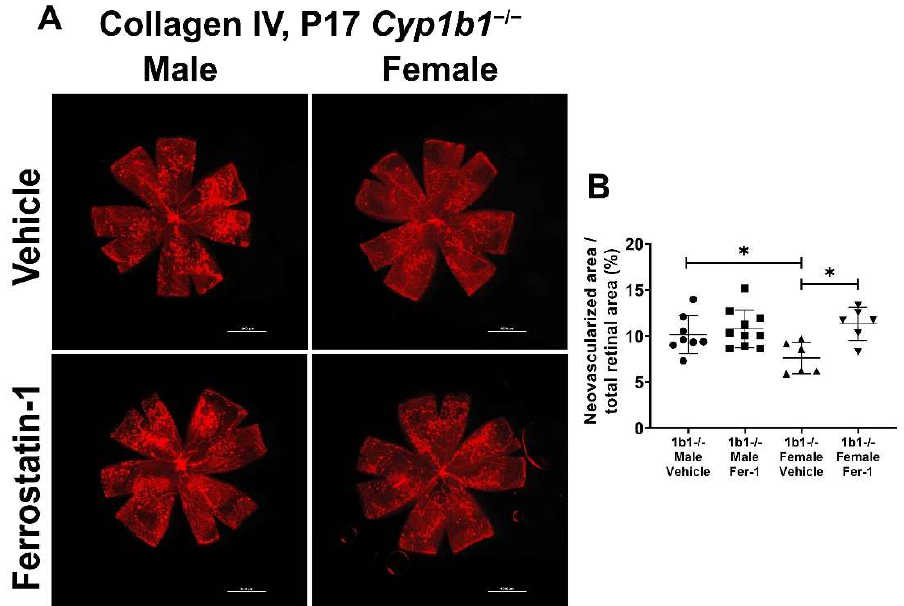
Figure 9. Ferrostatin-1 (Fer-1) administration restored retinal neovascularization in female but not male Cyp1b1 −/− mice during OIR. Retinas from P17 Cyp1b1 −/− mice that were administrated with Fer-1 (5 mg/kg, daily IP injection prepared in 50 µL saline, from P12-P17) during OIR were wholemount stained with anti-collagen IV antibody and imaged by fluorescent microscopy ( A ). Scale bars = 1000 µm. Quantitative assessment of the neovascularization was performed using ImageJ and the percentages of neovascular areas are shown in ( B ). (* p < 0.05; n ≥ 6; each point represents one retina).